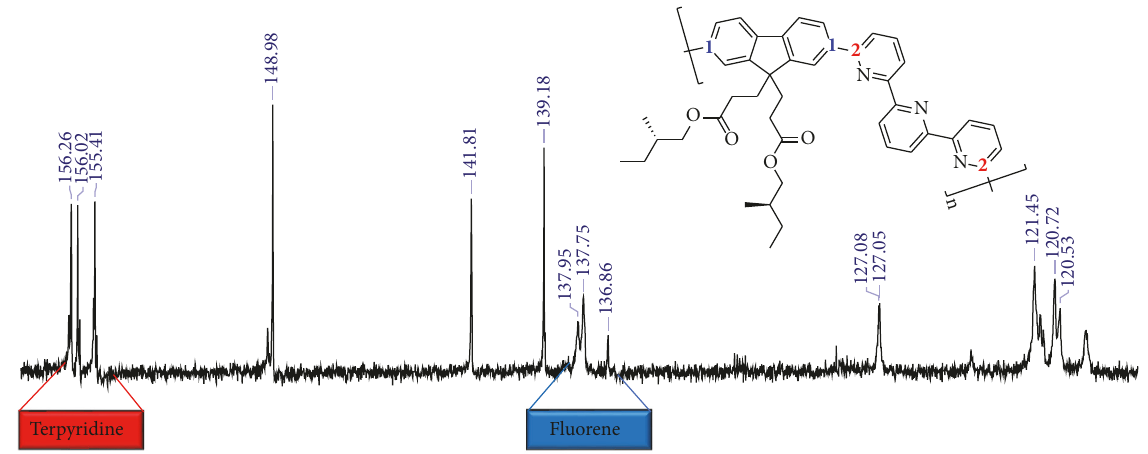
Figure 5: 13 C NMR spectrum of the LaPPS71, aromatic